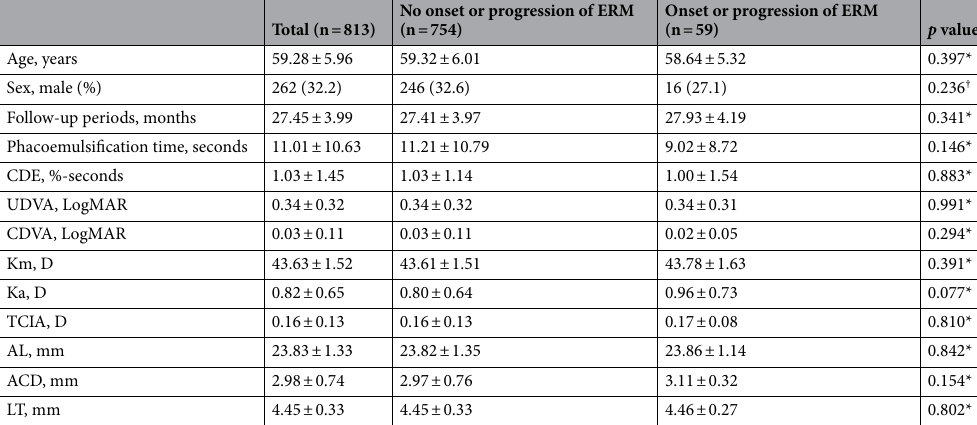
Table 1. Baseline characteristics of subjects in the present study. ACD anterior chamber depth, AL axial length, CDE cumulative dissipated energy, CDVA corrected distant visual acuity, Ka keratometric astigmatism, Km mean keratometric value, LT lens thickness, TCIA total corneal irregular astigmatism, UDVA uncorrected distance visual acuity. Data are mean ± standard deviation unless otherwise indicated. Student’s t-test* or Chi- square test † was